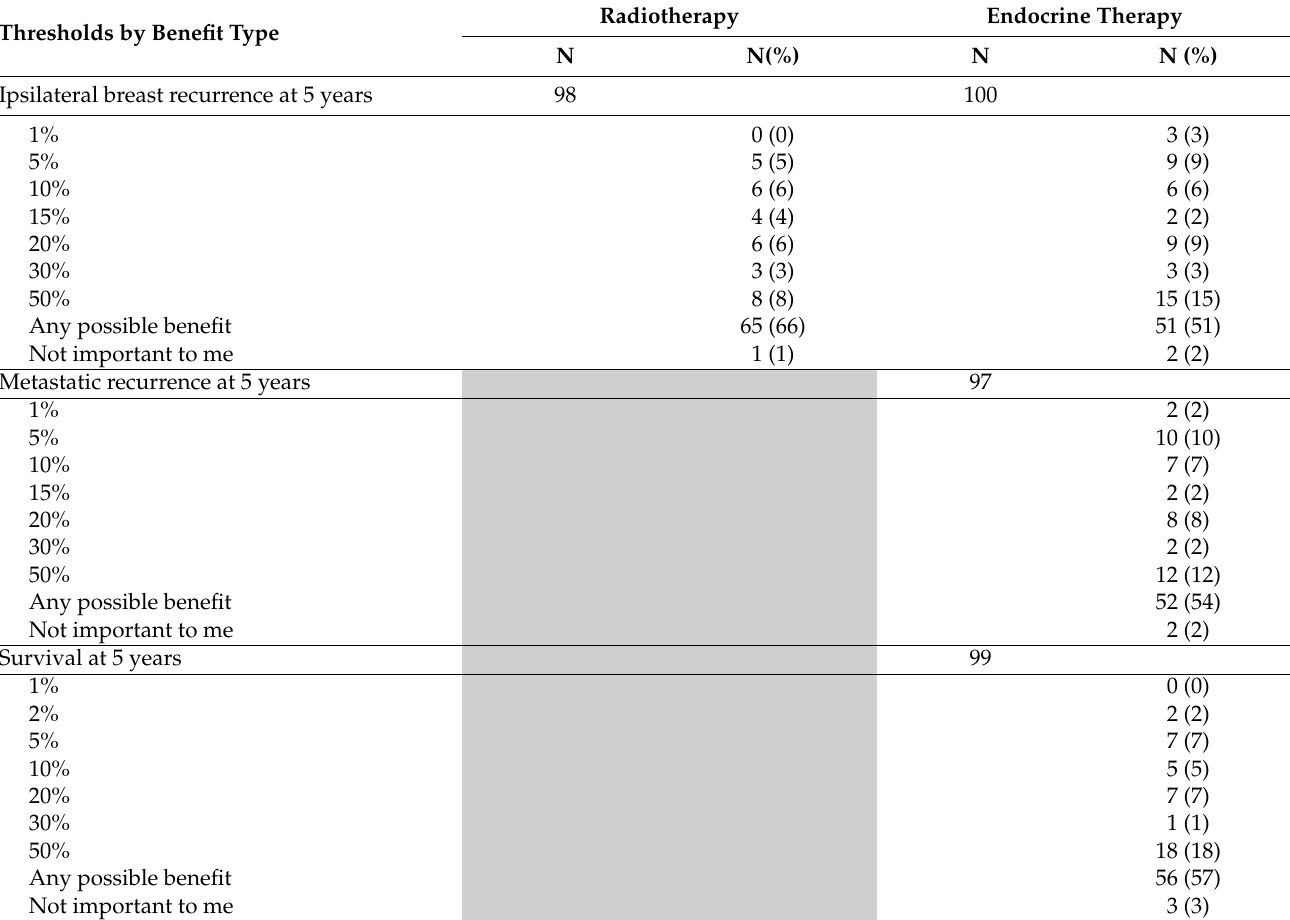
Table 3. Acceptable benefit threshold of radiotherapy and endocrine